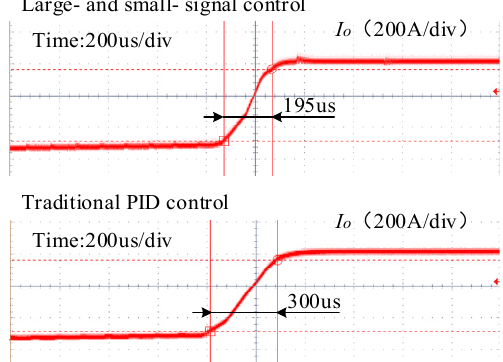
Figure 18. Large signal control output waveform in AC mode.